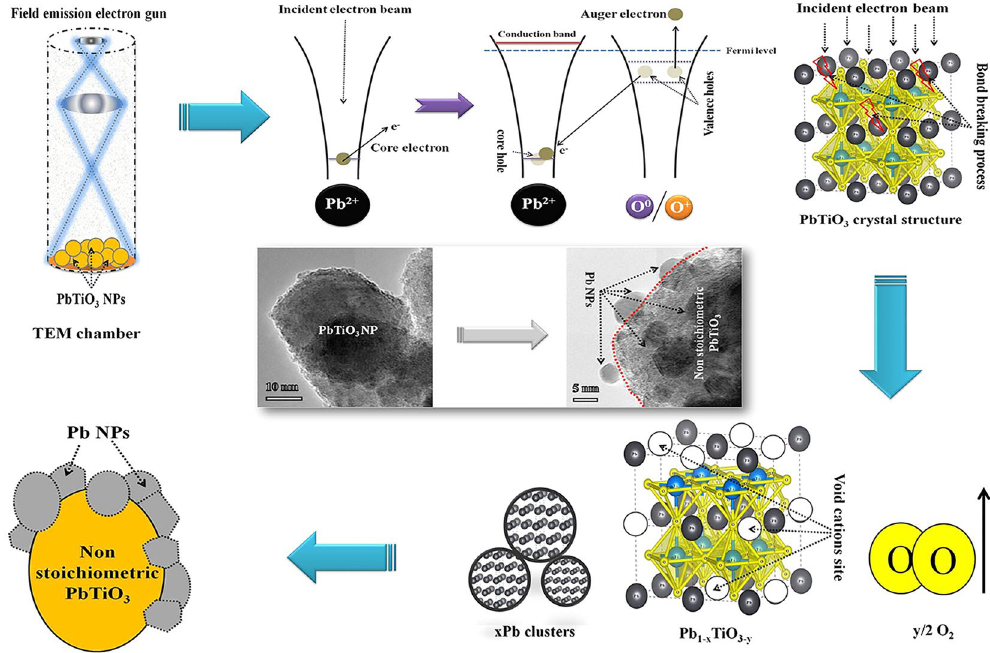
Figure 8. A schematic expression of formation of xPb-Pb 1-x TiO 3-y via Knotek-Feibelmen (KF)